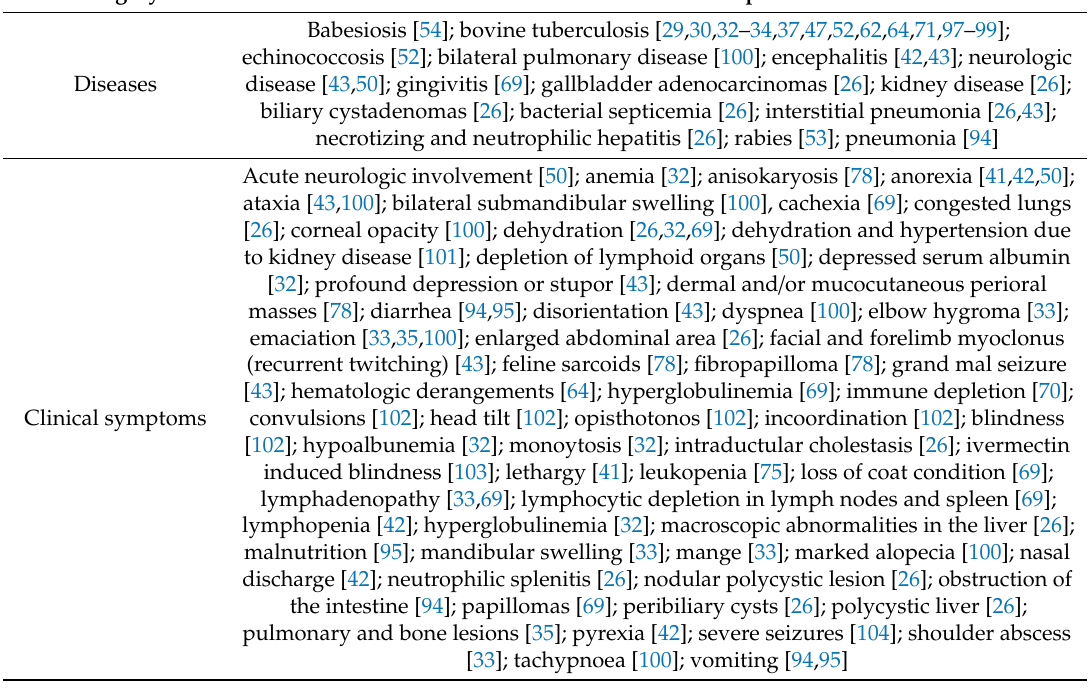
Table 2. Associated diseases and clinical symptoms recorded in the 148 papers in the dataset.